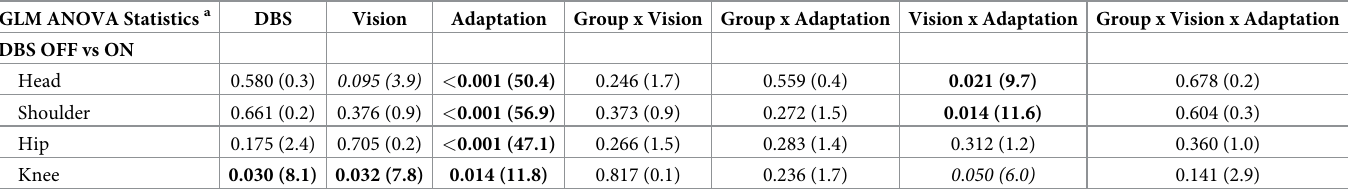
Table 2. DBS, vision and adaptation effects on the body posture. GLM ANOVA Statistics a